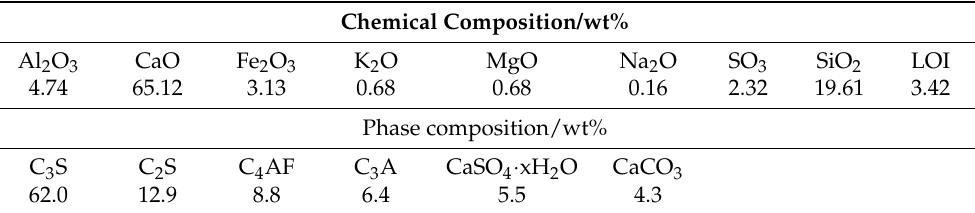
Table 1. Mineral composition and chemical composition of Portland